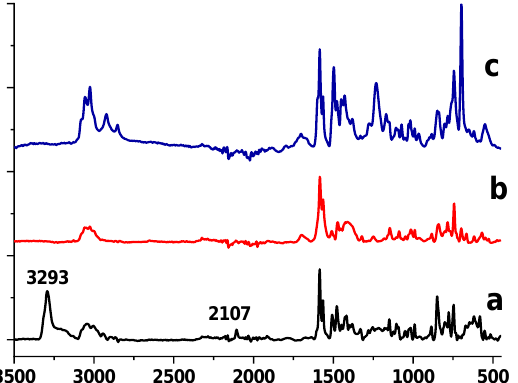
Figure 4. FTIR spectra of the dendrimer ( a , black line), the composite of dendrimer with Ni(acac) 2 prepared at 240 °C ( b , red line) and PPP heated at 200 °C for 1 h ( c , blue line).